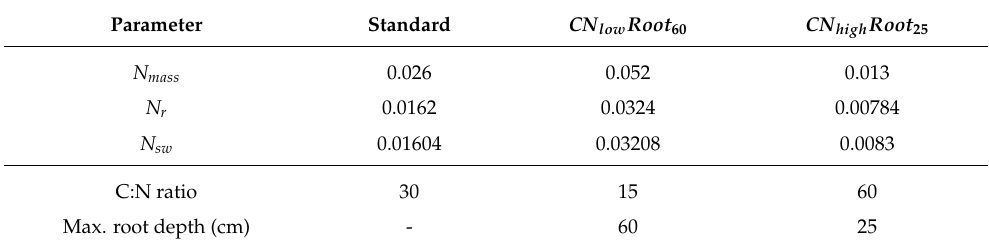
Table A2. Table of modifications for different Carbon-Nitrogen (CN) ratio cases. N mass is the top leaf N content per unit mass; N r is root nitrogen concentration (kg[N]/kg[C]) and N sw is stemwood nitrogen concentration (kg[N]/kg[C]). Here, standard indicates the standard JULES model configuration, whilst CN low Root 60 represents E. hermaphroditum and CN high Root 25 represents R. chamaemorus .